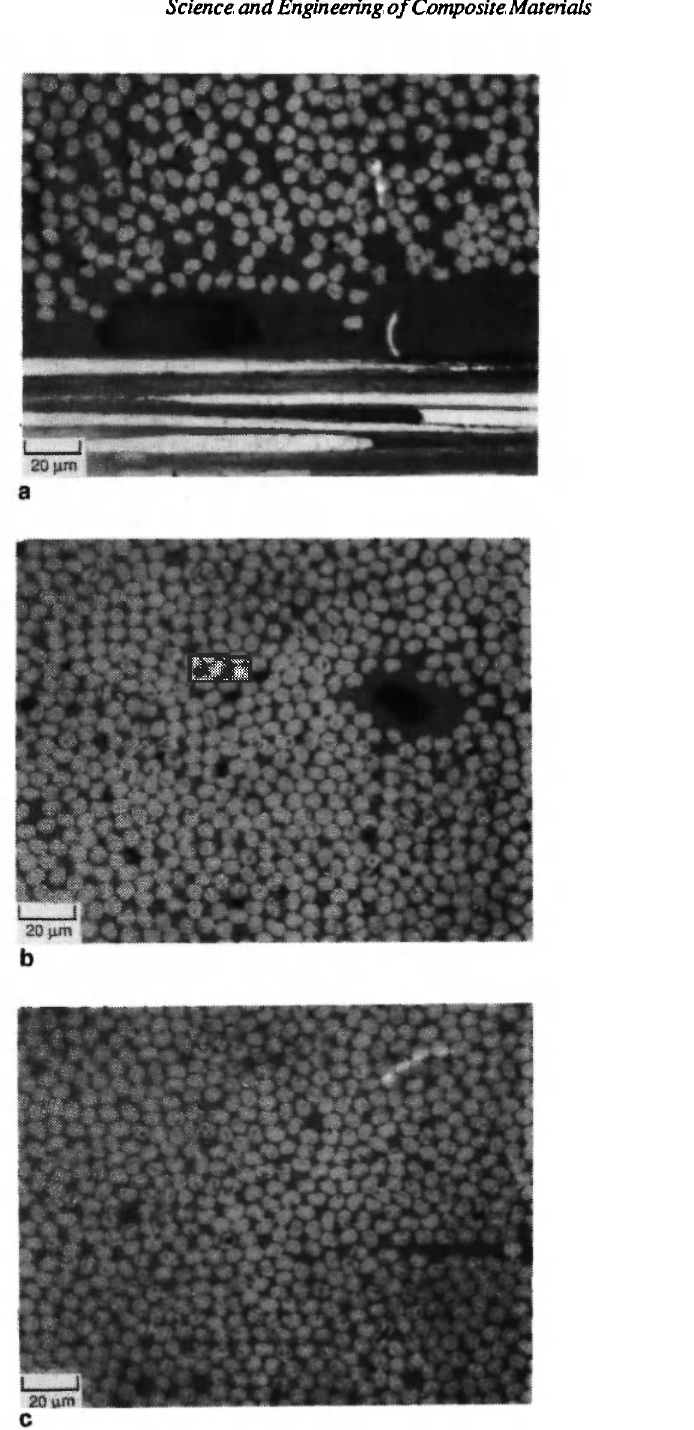
Fig. 9: Optical micrograph of